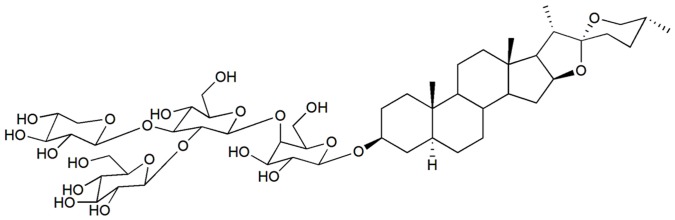
Structure of Isolated Compound.Structure of desgalactotigonin (DGT).